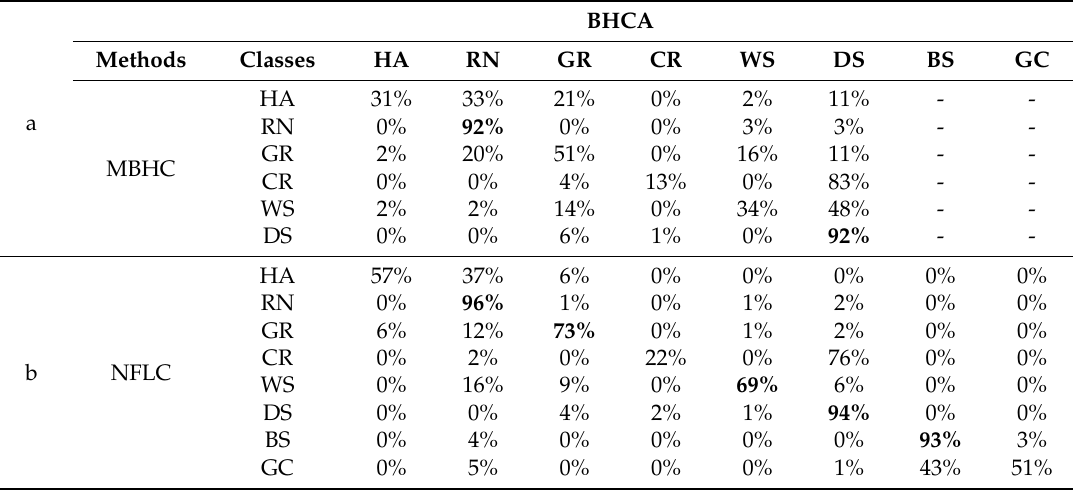
Table 5. ( a ) Agreement of classification between the BHCA and MBHC during 18:04–22:57 LST on 30 July and 08:03–09:04 LST on 24 July, 2014. (The numbers in the table represent the percentages of the hydrometeor types in the column identified as the ones in the row. Bold font indicates good consistency); ( b ) Similar to Table 5a, but for agreement of classification between the BHCA and